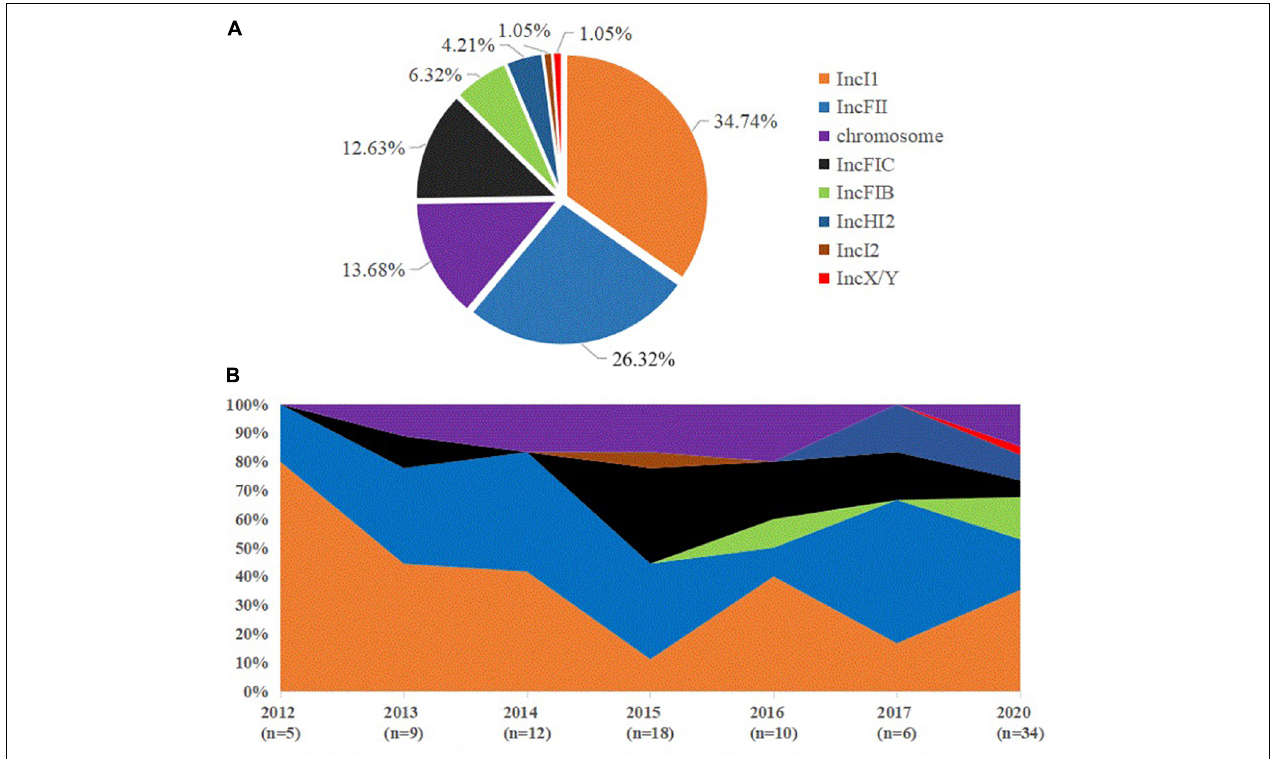
FIGURE 4 | Distribution of bla CTX − M − 55 gene location and dynamic changes in the incompatible group of plasmids in all the bla CTX − M − 55 -positive E. coli isolates. (A) The percentage of bla CTX − M − 55 gene location found in all bla CTX − M − 55 -positive E. coli isolates. (B) Percentage dynamics in major incompatible plasmids and chromosomes per year (missing data from 2018 to